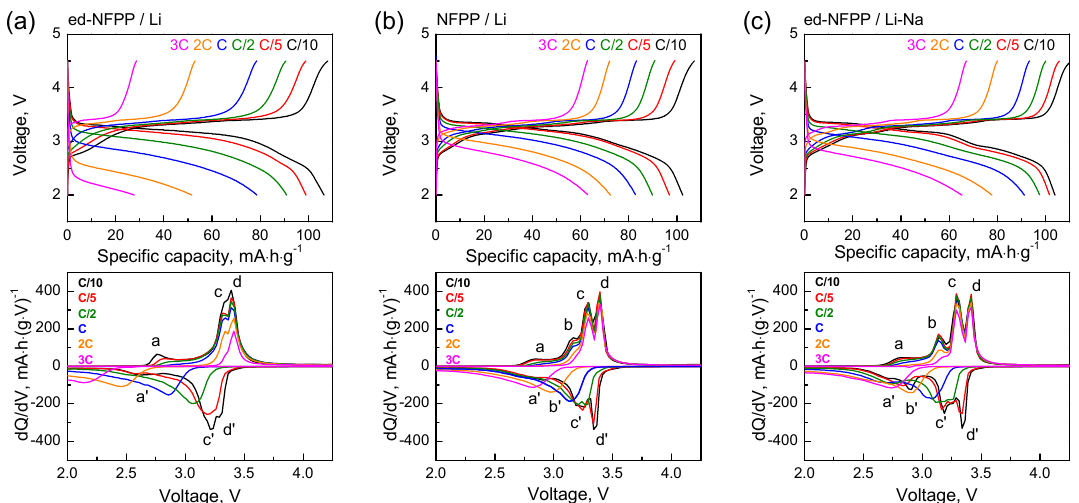
Figure 4. Charge-discharge profiles and dQ/dV vs. voltage plots for ed-NFPP/Li ( a ), NFPP/Li ( b ) and ed-NFPP/Li-Na ( c ) at different cycling rates.